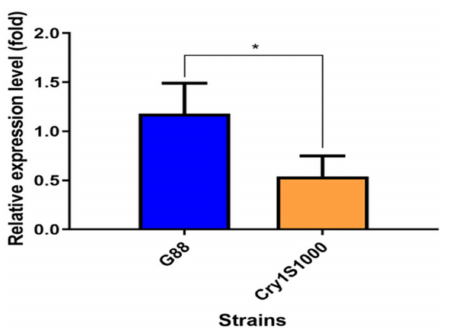
Figure 1. Relative expression level of the PxMetAP1 gene in the midgut of the 4th instar larvae of the G88 and Cry1S1000 strains. Independent samples t -test was used to analyze the differences between the two strains, where * denotes a significant difference ( p <